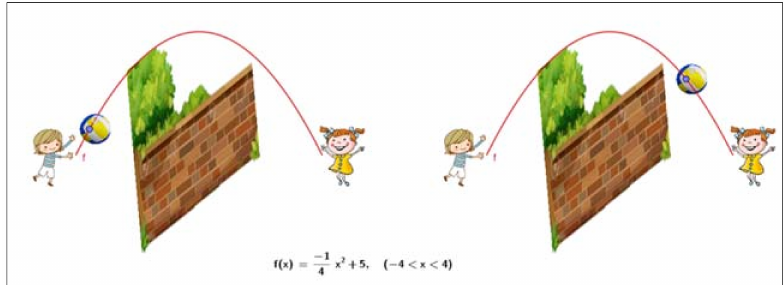
Figure 2. Participant 9; mathematics task assignment, item 15a.